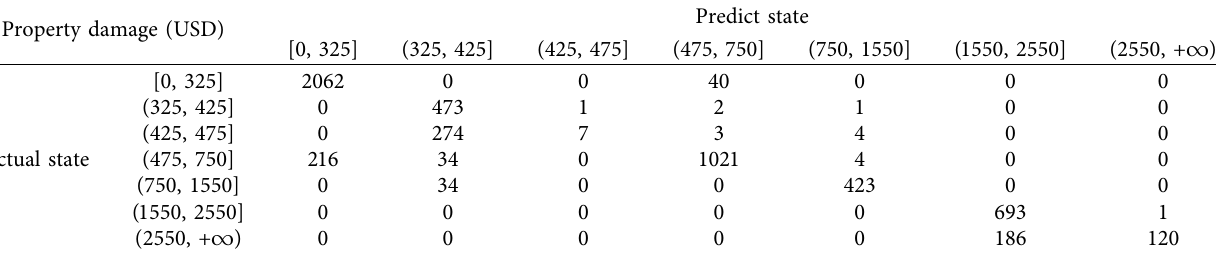
Table 6: Te confusion matrix for property damage.